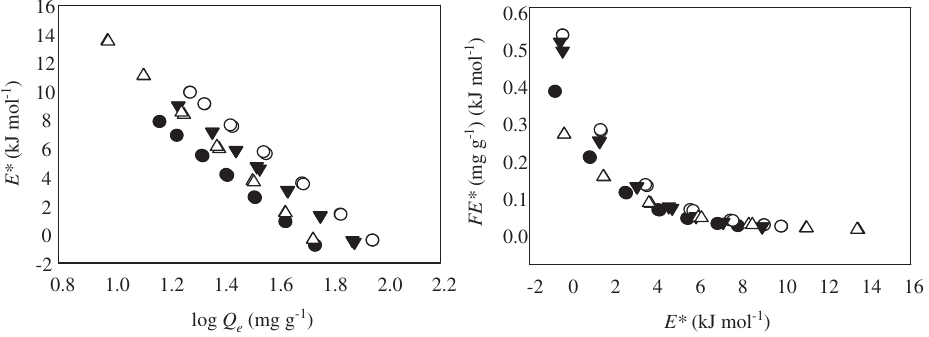
Figure 6: Plots of site energy distribution of methylene blue dye adsorption. E * is the net energy and F ( E* ) is site energy distribution. Symbols (● and ○) and ( ▾ and Δ ) represent multi-walled carbon nanotubes (MWCNTs) and oxidized MWCNTs (MWCNTs-Ox). Closed and open symbols represent temperatures 298 K and 318 K,